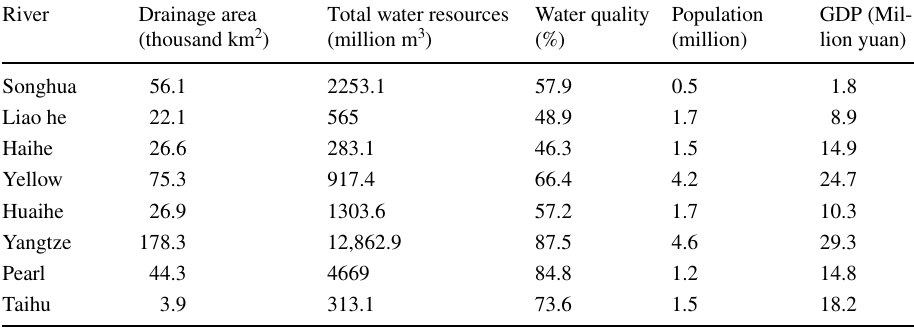
Table 1 The basic situation of eight rivers and lakes in China